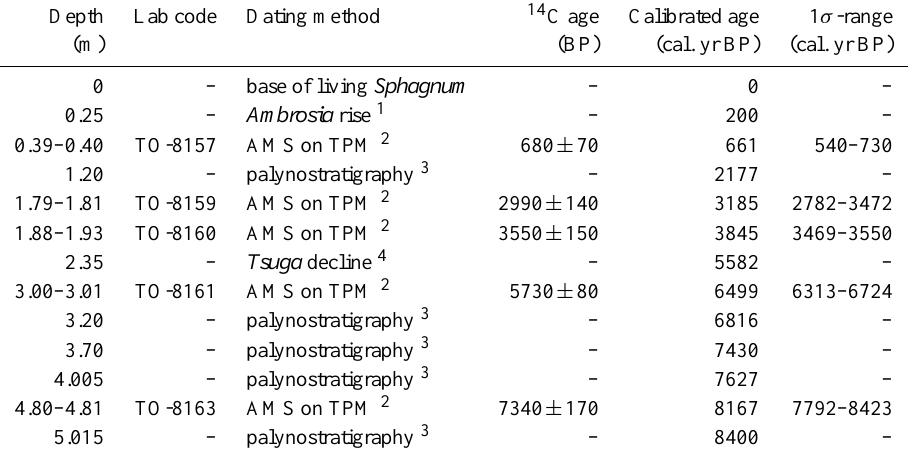
Table 3. Chronological data for core